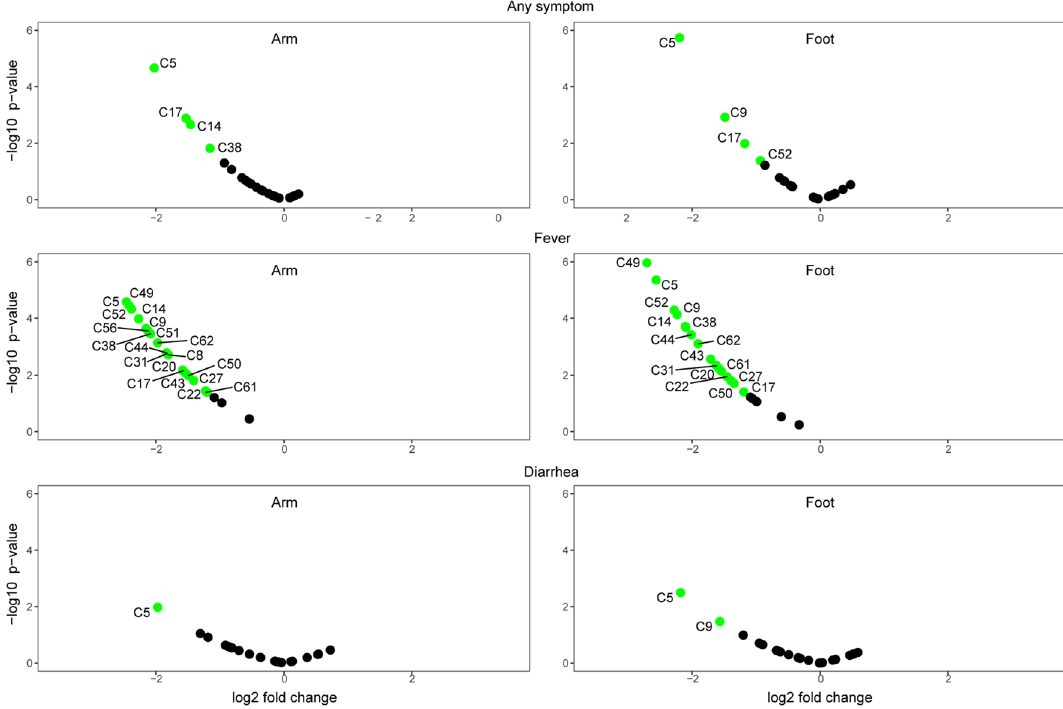
Figure 2. Volcano plots showing changes in individual compounds in malaria-infected symptomatic children relative to malaria-uninfected symptomatic children. Significantly up- or downregulated compounds ( p < 0.05 and absolute fold change > 1.5) are shown in green. Compound IDs are listed in Table